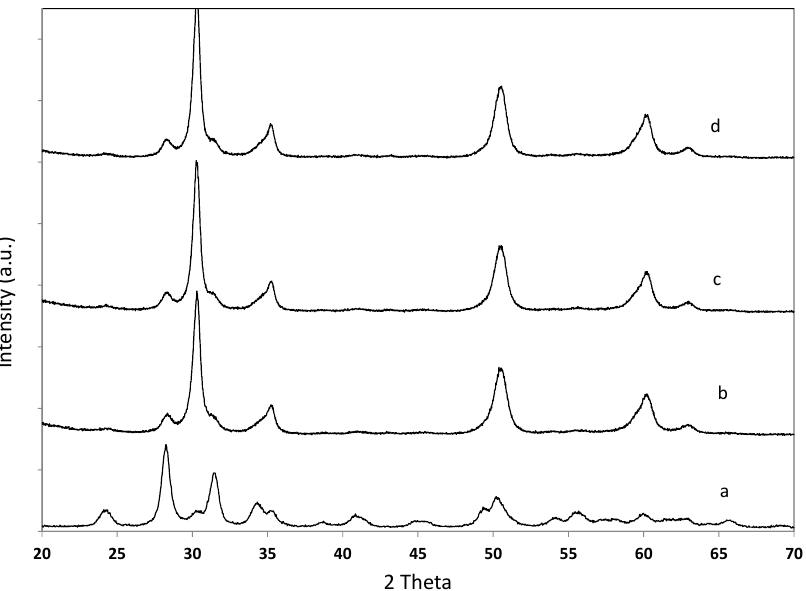
Figure 2. XRD patterns of support and catalysts. ( a ) ZrO 2 , ( b ) Ag1Z, ( c ) Ag5Z, and ( d ) Ag10Z.